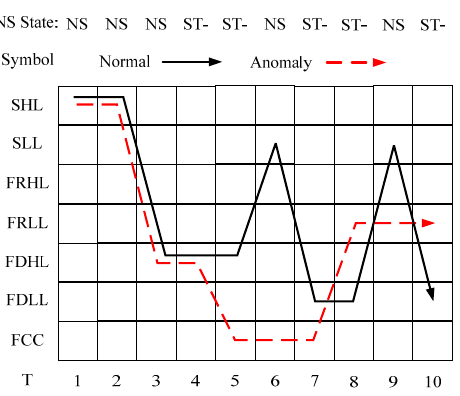
Figure 14. Comparison between a normal sequence and an anomaly sequence in symbolic description.